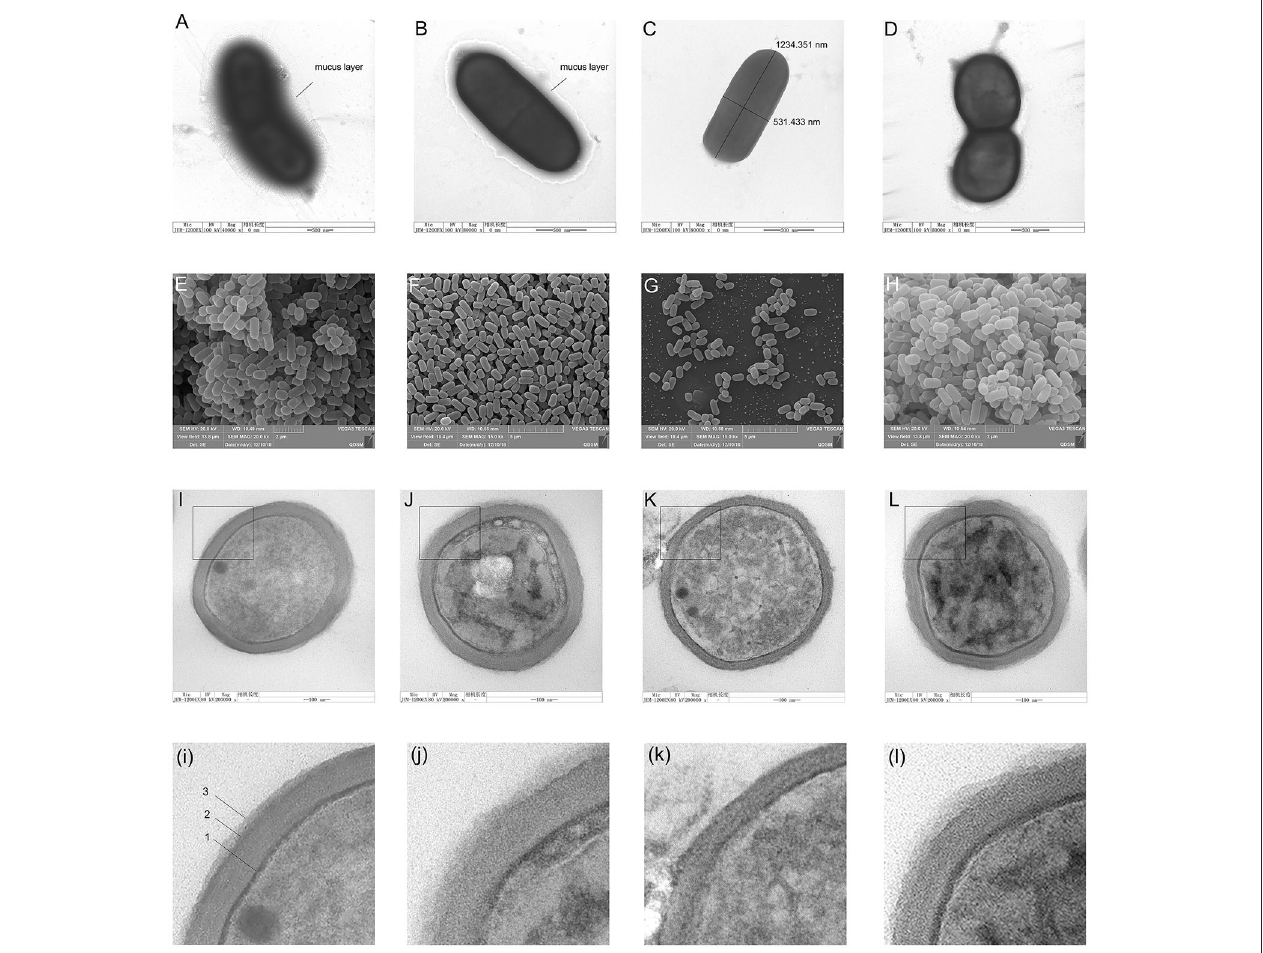
FIGURE 2 | The morphological changes of cells were observed by negative staining electron microscopy, scanning electron microscopy (SEM), and transmission electron microscopy (TEM). Figures from (A–D) shows the negative staining with uranyl formate on the carbon support films of Lactobacillus plantarum HC-2. Bacteria are adsorbed on the surface of carbon support films from aqueous suspensions containing typically 10 8 CFU/mL and subsequently stained with 0.75% of uranyl formate solutions. (A), intact L. plantarum HC-2. (B), L. plantarum HC-2 was treated with LiCl for 3h. (C), L. plantarum HC-2 was treated by LiCl for 9h. Figures from (E–H) show the view of L. plantarum HC-2 through SEM. (E), intact L. plantarum HC-2 showing the bacterial aggregation. (F), L. plantarum HC-2 was treated with LiCl for 3h showing that the cells were separated. (G), L. plantarum HC-2 was treated with LiCl for 9h. Figures from (I–L) show the view of L. plantarum HC-2 through TEM. (I), intact L. plantarum HC-2 showing a three-layered structure on the cell wall (arrows: 1, plasma membrane; 2, cell wall; 3, the S-layer). (K), L. plantarum HC-2 was treated with LiCl for 9h showing that the cell wall has become thin and the outermost layer is missing. (L), L. plantarum HC-2 was treated with LiCl for 9h and reproduced surface proteins. The graphs of i, j, k, and l are a partial magnification of I, J, K, and